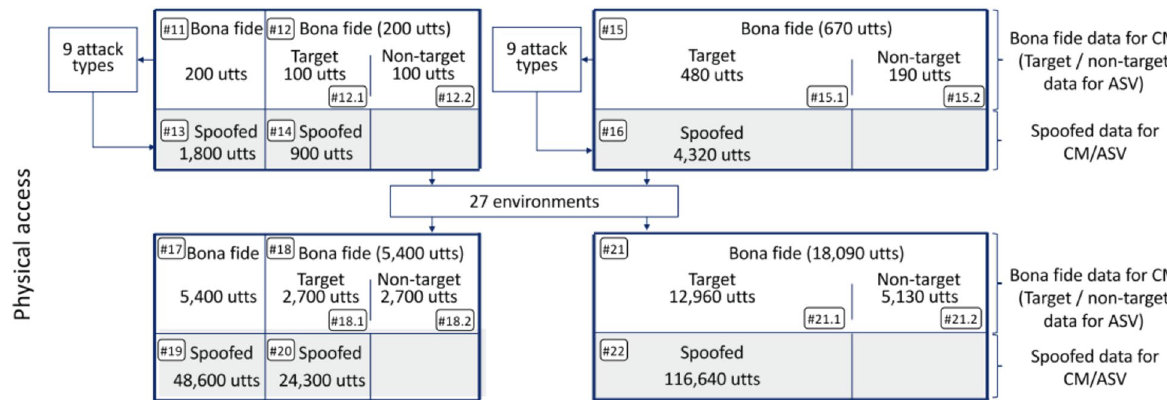
Fig. 5 Statistics of the